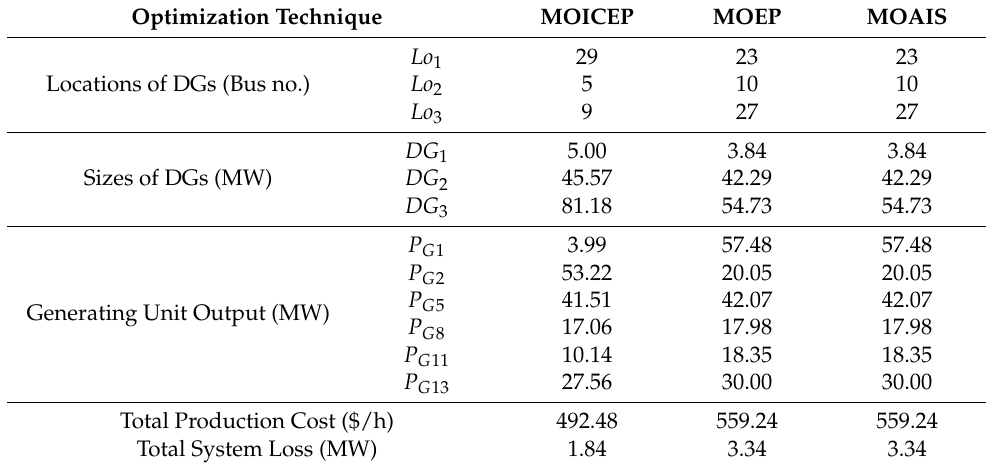
Table 12. Results of the integrated ED problem with prohibited operating zones and DG installation of the IEEE 30-Bus RTS ( w 1 = 0.5 and w 2 = 0.5). Optimization Technique MOICEP MOEP MOAIS Lo 1 29 23 Lo 2 Locations of DGs (Bus no.)